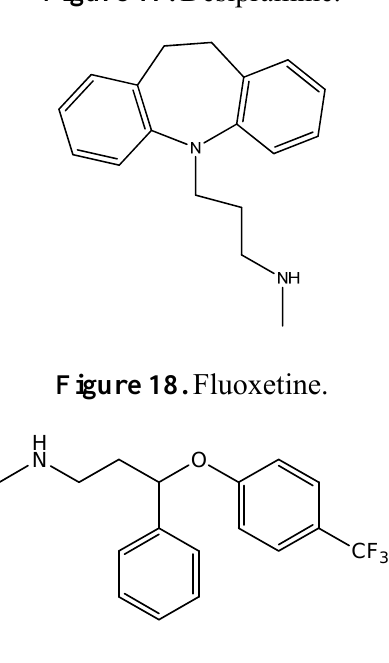
Figure 17. Desipramine.